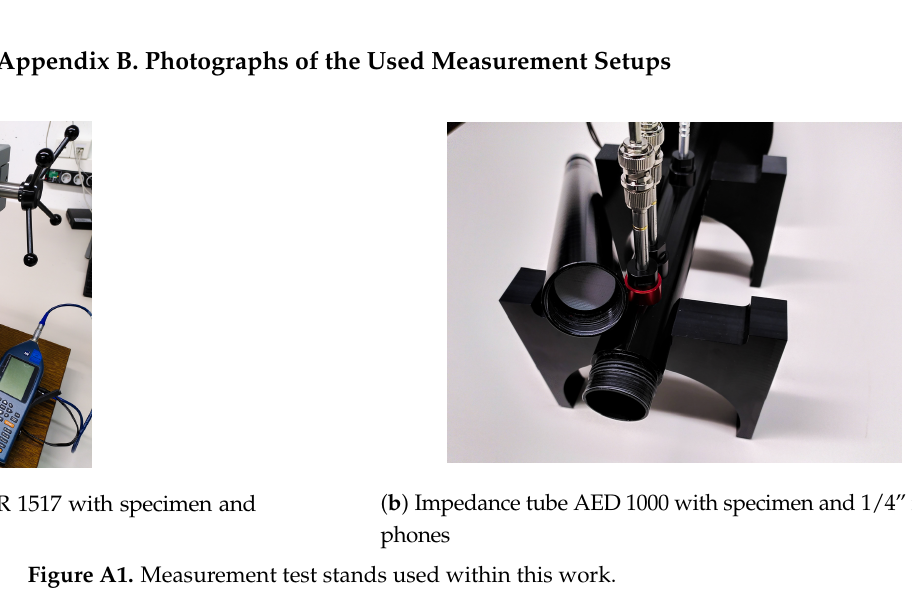
Figure B.1. Measurement test stands used within this work.